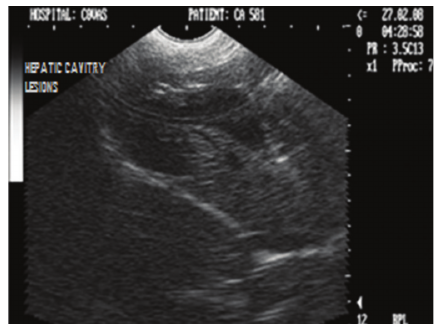
Figure 35: Ultrasonogram (2D) of liver in longitudinal scan revealing large poorly echogenic area with internal septations in a one and half-year-old neutered male Doberman pinscher dog.